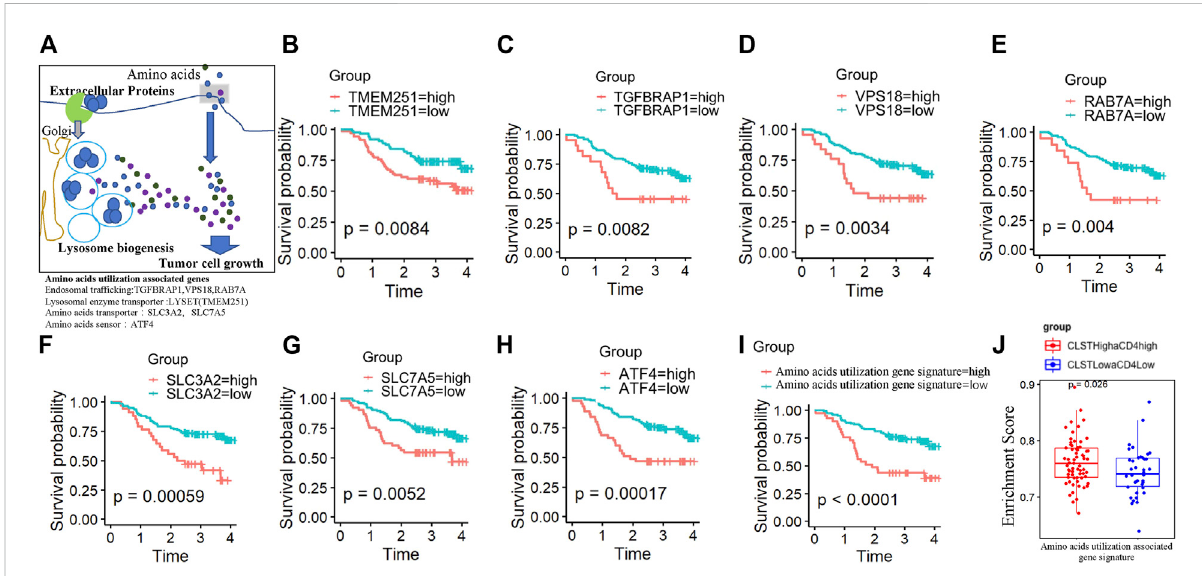
FIGURE 5 The prognostic value of nutritional utilization of the amino acid-associated gene signature in HBV-HCC (A) Lysosomal nutrient generation and nutritionalutilizationofaminoacidsfortumorcellgrowth.LYSET(TEME251),ATF4,VPS18,RAB7A,SLC7A5,TGFBRAP1,andGNPTABwereinvolvedin this process. (B – H) Plots depict the KM survival curves for each nutritional utilization of amino acid-associated genes in HBV-HCC patients from the CHCCcohortdividedintolowandhighexpressiongroupsaccordingtothegeneexpressionvalue. (I) KMsurvivalcurvesforOSintumortissues of HBV-HCC patients from CHCC cohort with a high ES of the “ nutritional utilization of amino acid-associated gene ” signature and a low ES of the “ nutritional utilization of amino acid-associated gene ” signature. (J) Differences in the enrichment levels of the “ nutritional utilization of amino